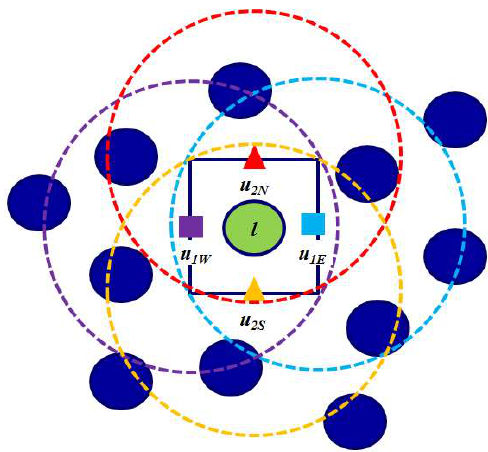
Figure 1. Schematic view of the staggered divergence-free model.